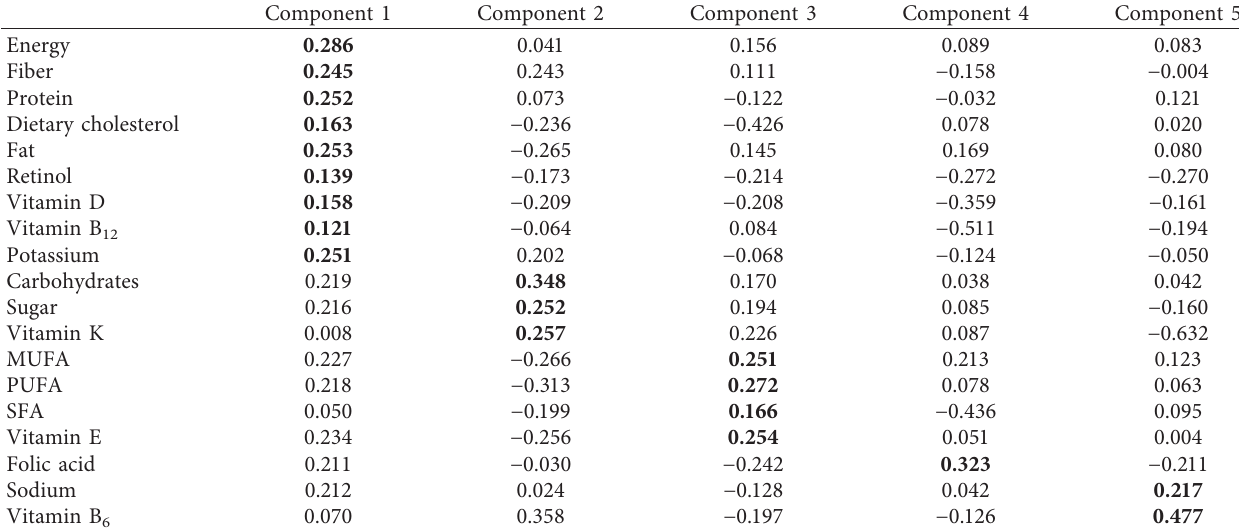
Table 5: Results of the principal component analysis of the nutritional intake. Component